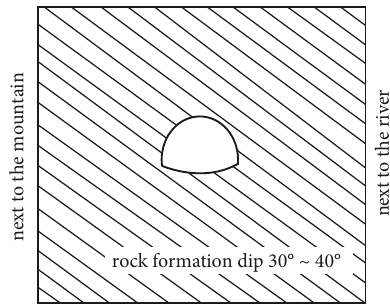
Figure 8: Schematic diagram of tunnel rock formation.